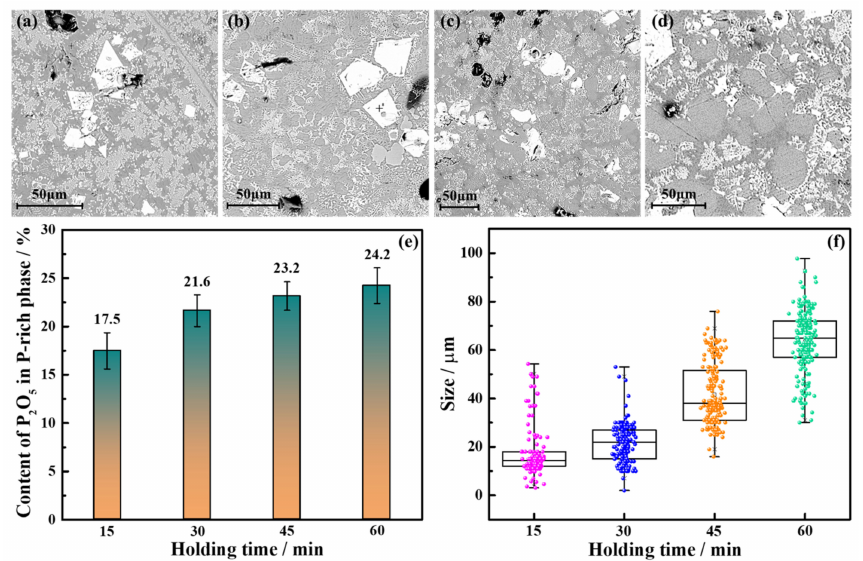
Figure 5. ( a – d ) Microscopic appearance of high phosphorus steel slag ( e ) P 2 O 5 content and ( f ) size of phosphorus-rich phase under different holding